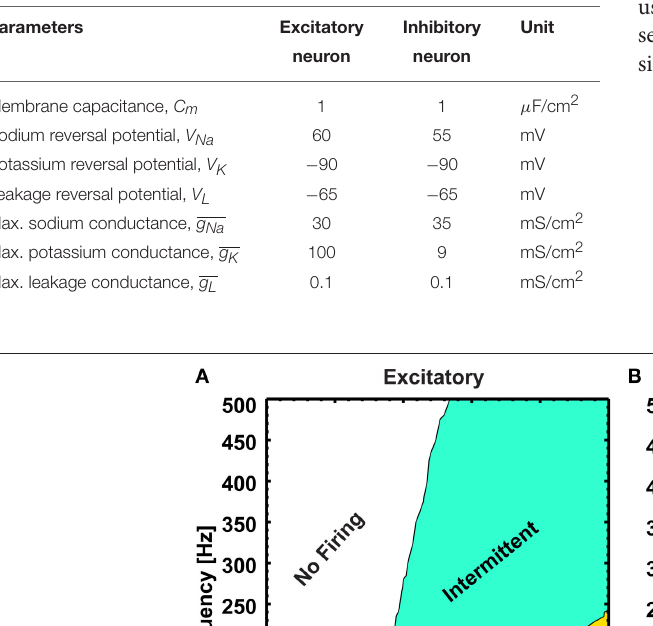
TABLE 1 | Constants and parameters for individual neuron classes with their units.